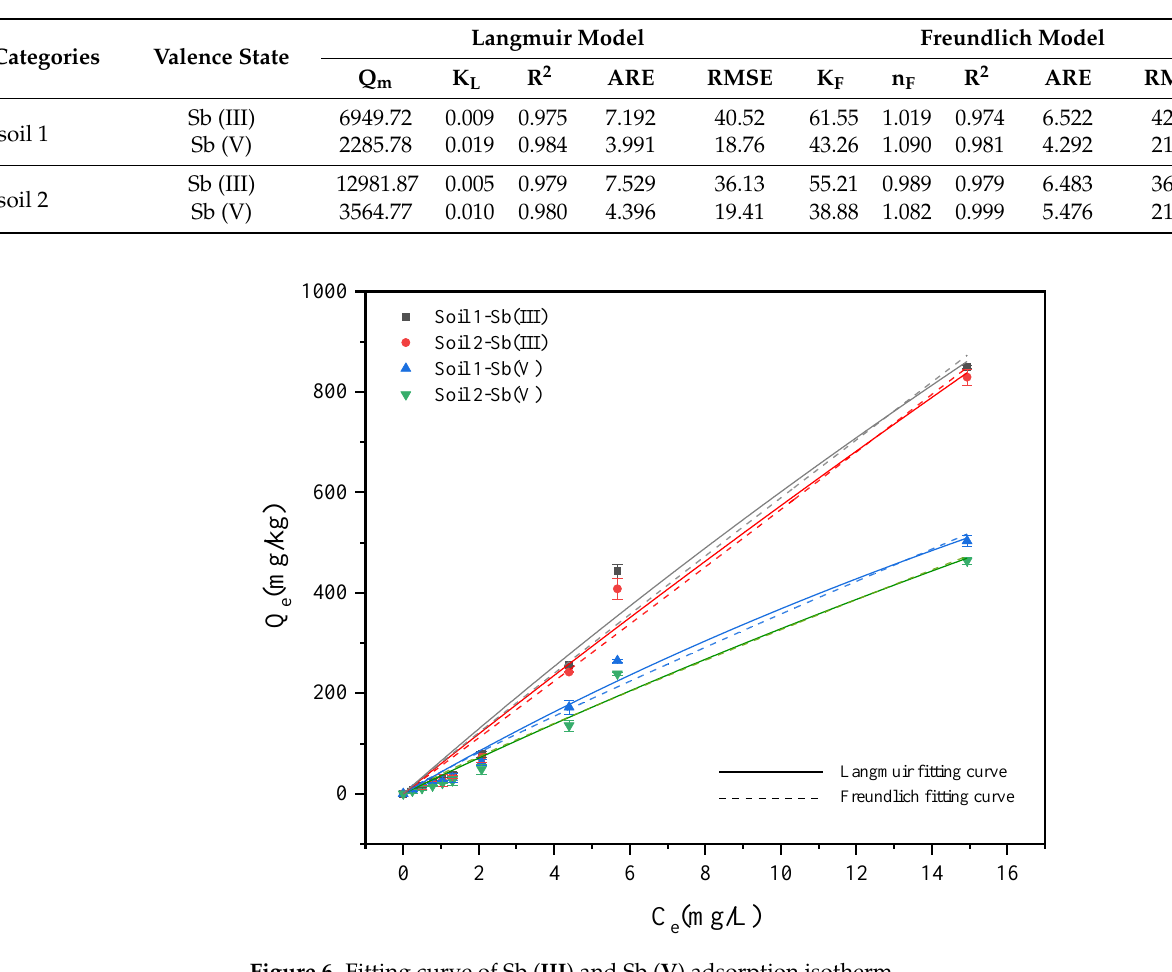
Figure 6. Fitting curve of Sb ( III ) and Sb ( V ) adsorption isotherm.